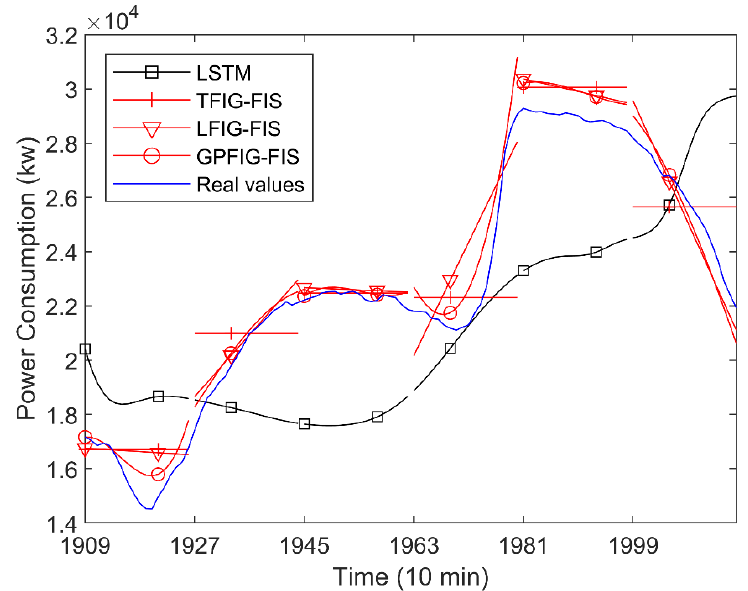
Figure 12. Electricity consumption forecast results of Tetuan city.